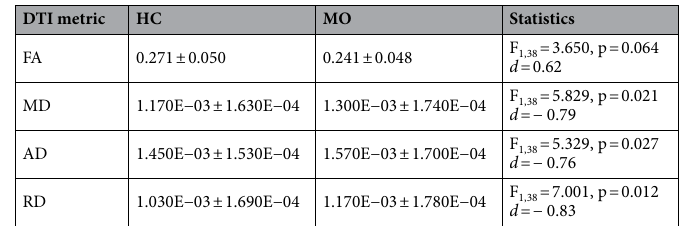
Table 2. Descriptive and univariate statistics for the hypothalamus fractional anisotropy (FA), mean diffusivity (MD), axial diffusivity (AD), and radial diffusivity (RD) in HC and MO.